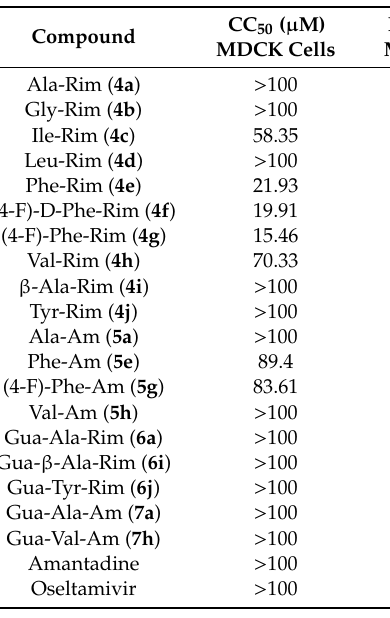
Table 1. Cytotoxicity concentration, high-nontoxic concentration and inhibition concentration of investigated